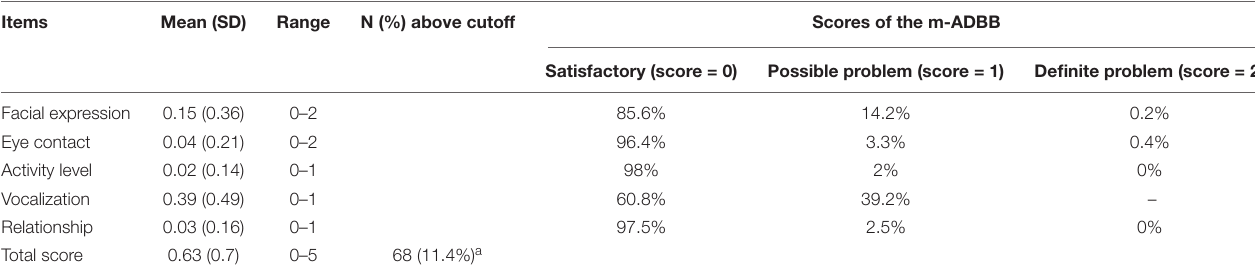
TABLE 7 | Mean (SD) and range of the Modified Alarm Distress Baby (m-ADBB) scale scores ( n = 597), % of children in each response category and number (%) of children scoring above cut off for social